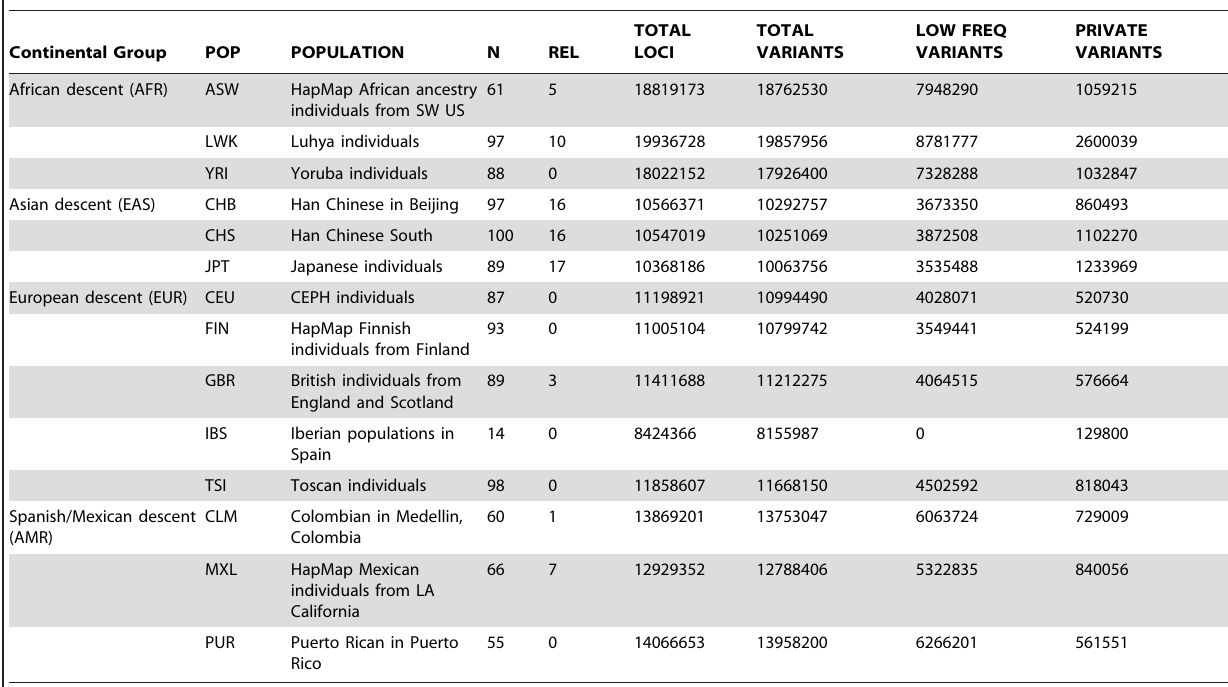
Table 1. Phase I 1000 Genomes Project data characteristics.